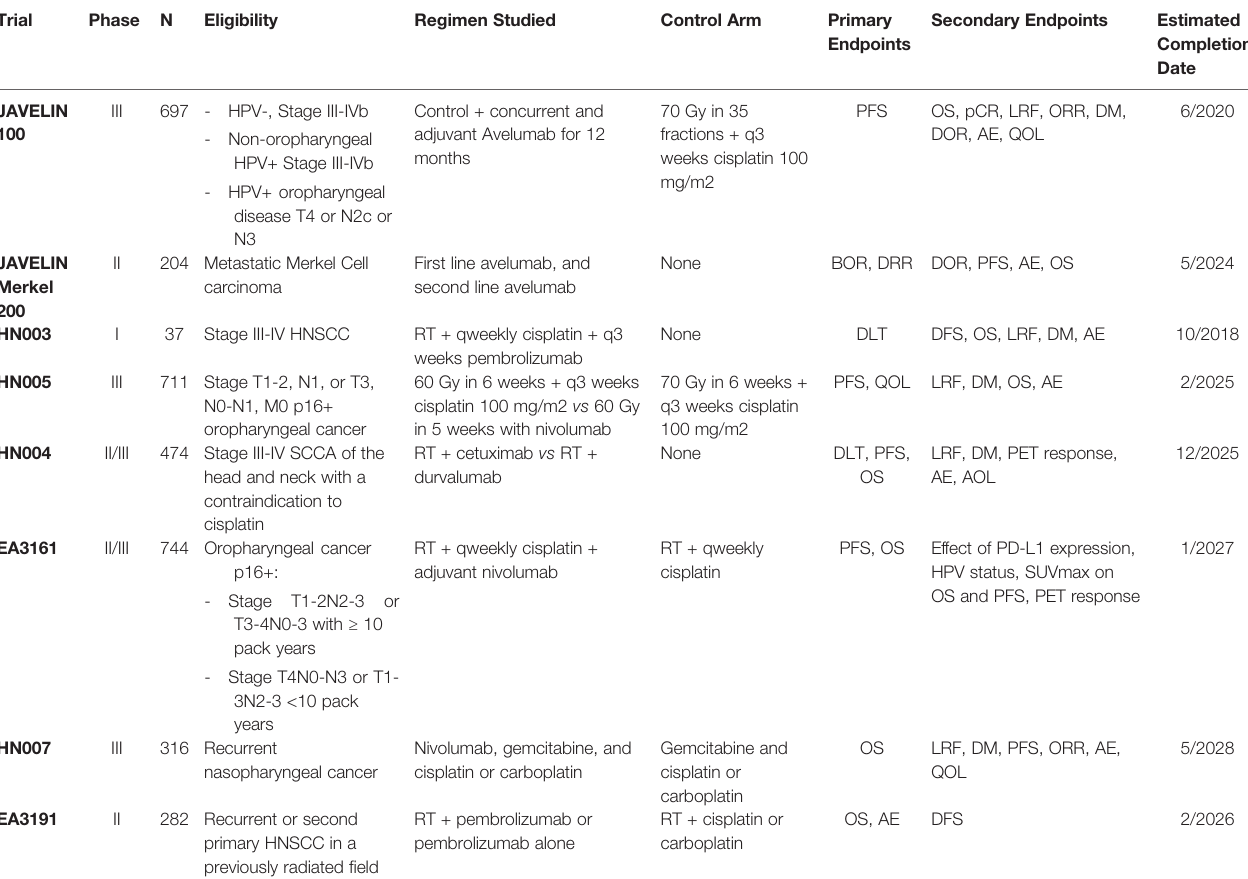
TABLE 1 | Select Ongoing Trials/Awaiting